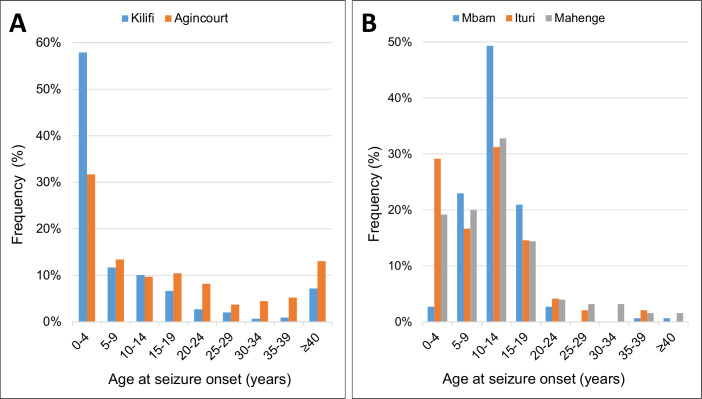
The ages of village residents at epilepsy onset (A) in non-onchocerciasis–endemic regions in Kilifi, Kenya and Agincourt, South Africa [50] (B) in onchocerciasis-endemic communities in Mbam, Cameroon [43], Ituri, DRC [53], and Mahenge, Tanzania [49].